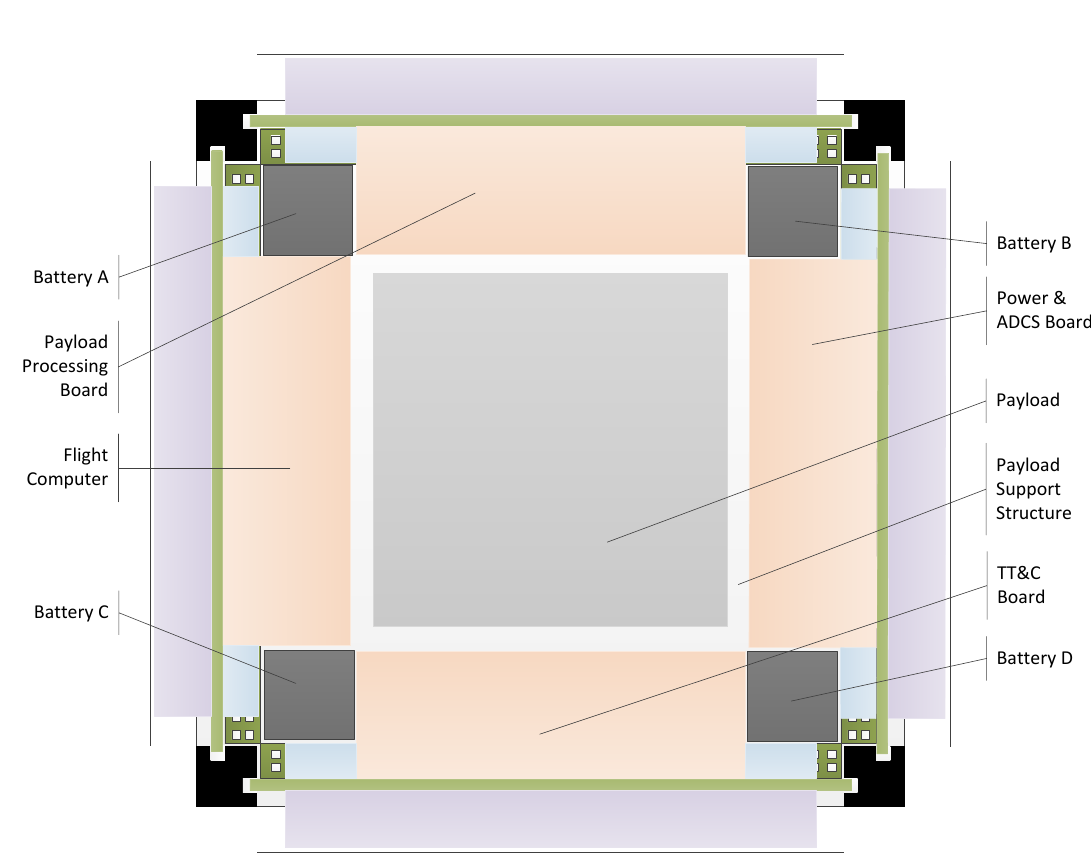
Figure 1. OpenOrbiter